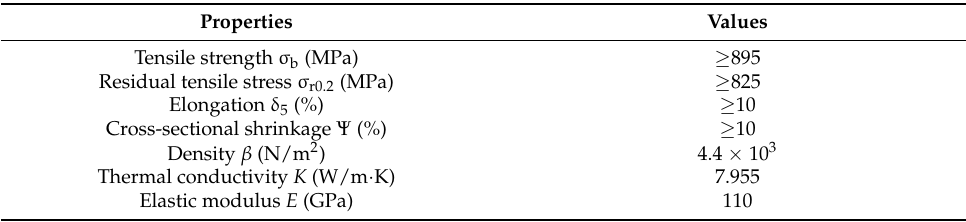
Table 1. The physical and mechanical properties of Ti-6Al-4V.